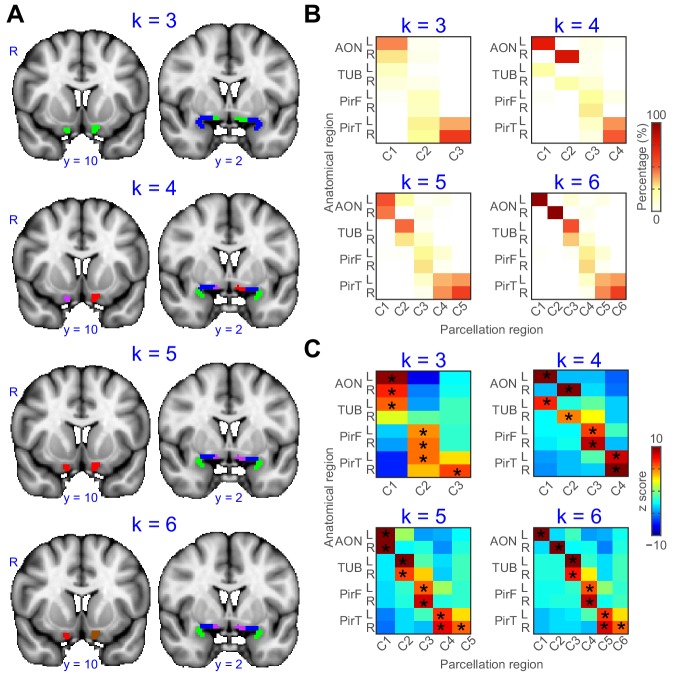
Parcellation of primary olfactory cortex combined across left and right hemispheres.(A) k-means clustering results shown on the FSL’s MNI152_T1_1mm_brain for k = 3 to 6. Each color represents one cluster. (B) Proportion of voxels of each parcellation subdivision within each anatomical subregion. (C) z score of the proportion maps in panel B. * indicates p<0.001 (false discovery rate corrected). L, left hemisphere; R, right hemisphere; AON, anterior olfactory tubercle; TUB, olfactory tubercle; PirF, frontal piriform cortex; PirT, temporal piriform cortex.10.7554/eLife.47177.011Figure 3—source data 1.Relates to Figure 3.Parcellation result (k = 3 to 6) of left and right hemispheres combined ROI.